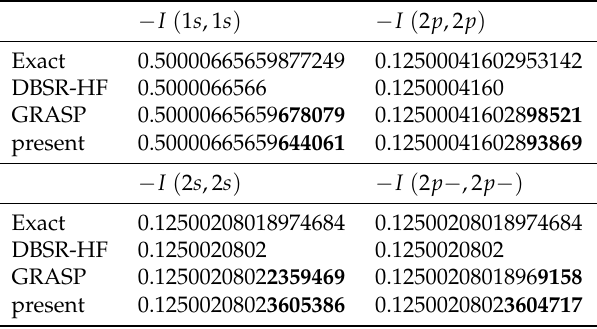
Table 3. Errors in relativistic results for I ( a , a ) integrals compared with GRASP and DBSR-HF. Bold digits are not